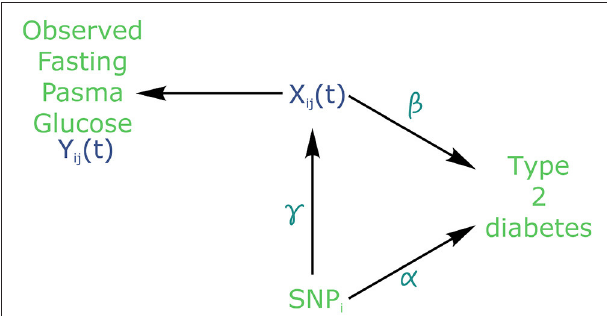
in RMSE for parameter α were smaller than for parameter β .